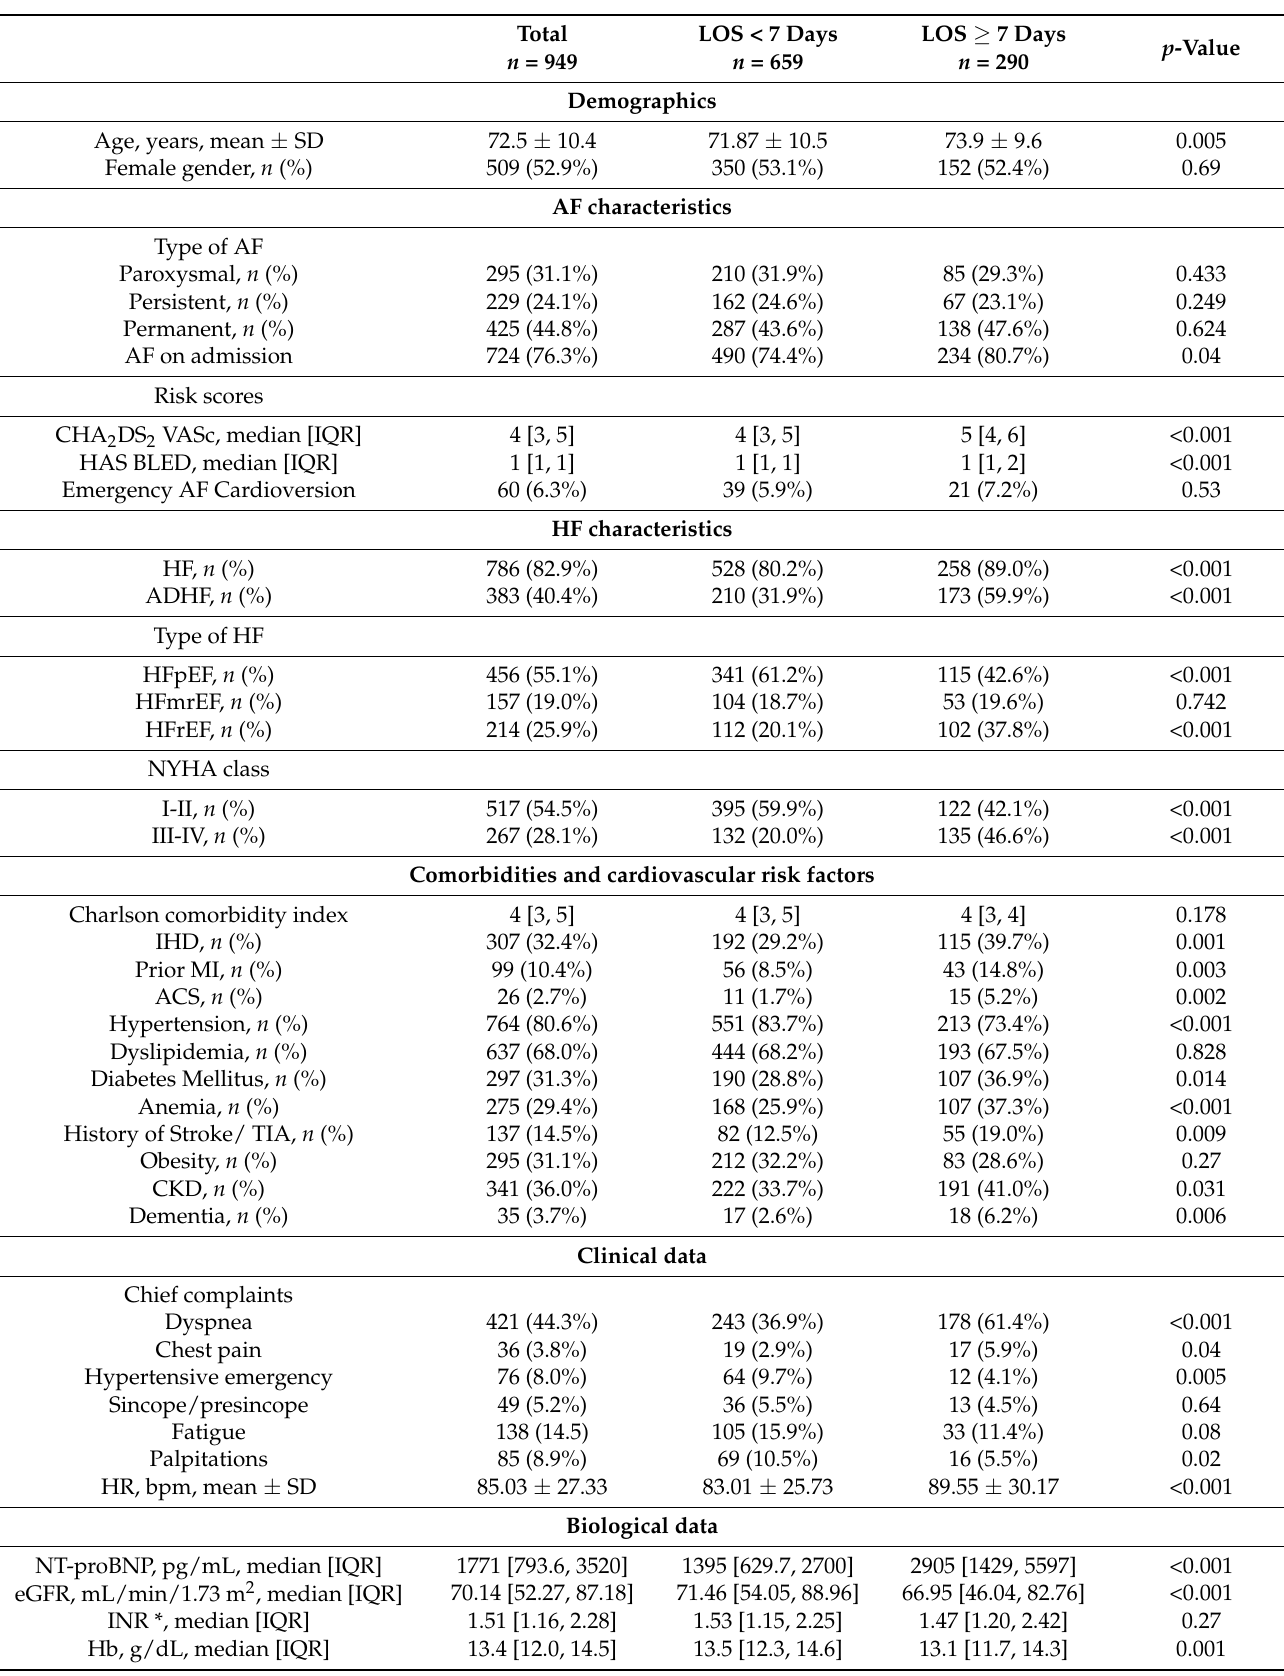
Table 1. Baseline characteristics of patients stratified by